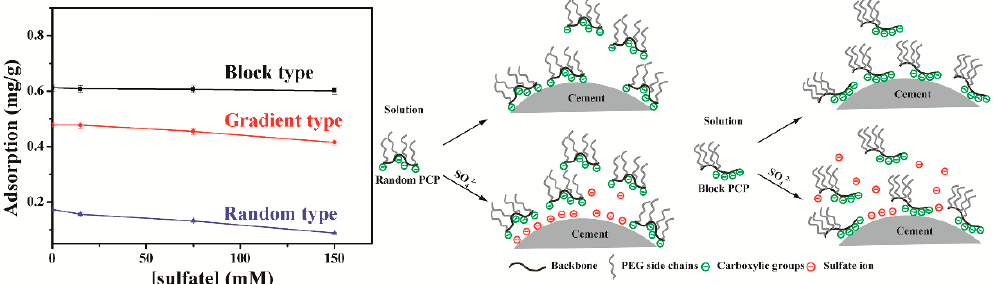
Figure 10. Adsorption of PCEs with different topological structures ( left ) and the working mechanism in the presence of sulfates ( right ). “Random PCP” and “Block PCP” are random-type and block-type PCE samples. Original figures from ref. [134].